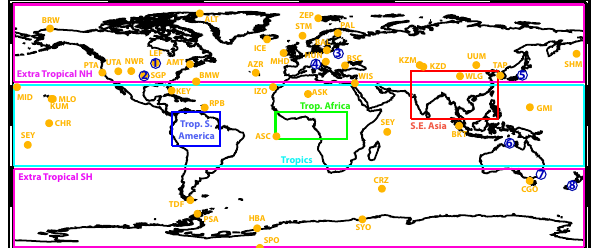
Fig. 1. Location of NOAA and TCCON sites used in this study, and of the regions used for integrating inversion-estimated fluxes. NOAA sites are indicated as yellow circles with corresponding site acronyms. The TCCON sites are indicated as blue circled numbers indicating 1: Park Falls, 2: Lamont, 3: Bialystok, 4: Garmisch,